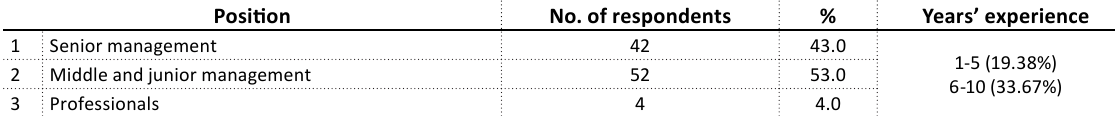
Table 4. Biographical profile of female officials (target group 1)